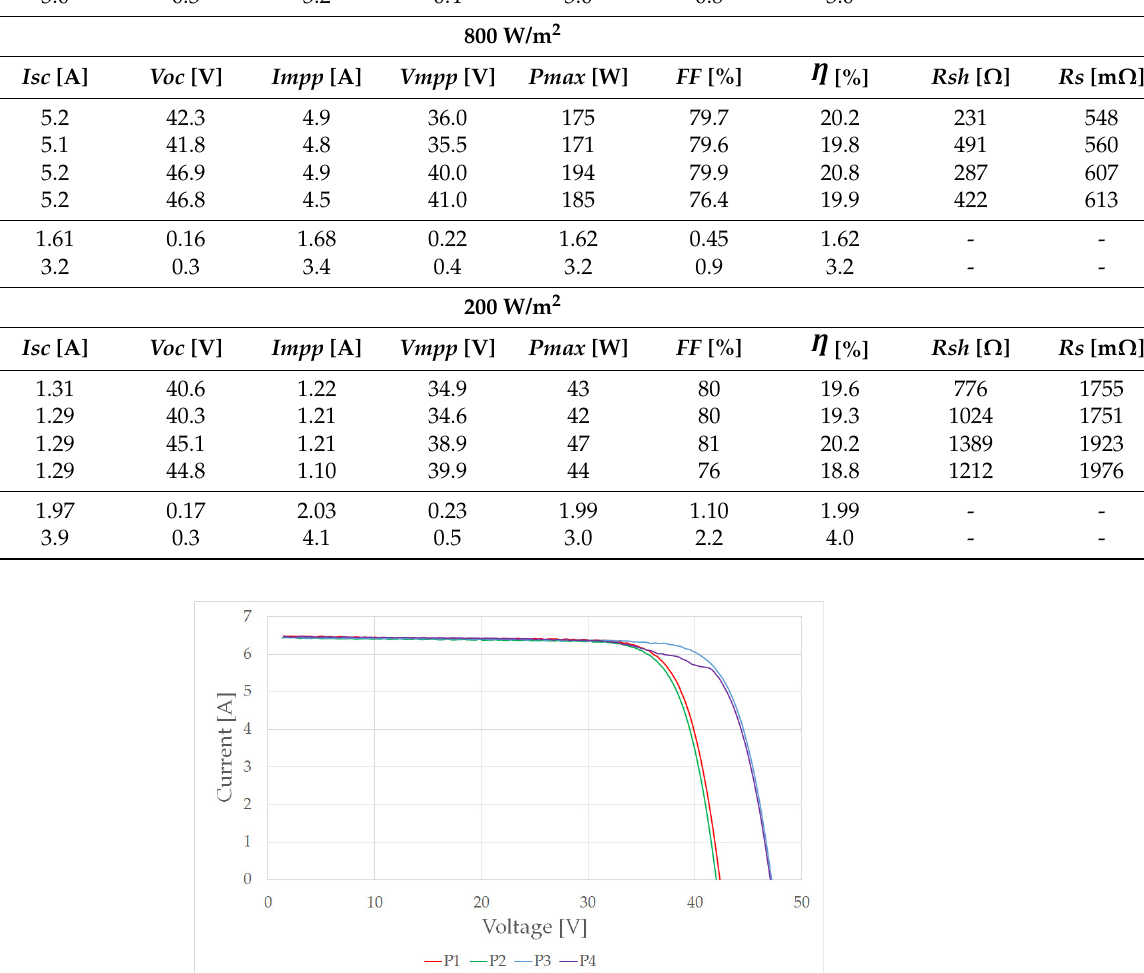
Table 4. Results of electrical parameters measurements for each prototype at different irradiance level with standard and expanded uncertainty. η 1000 W/m 2 No.